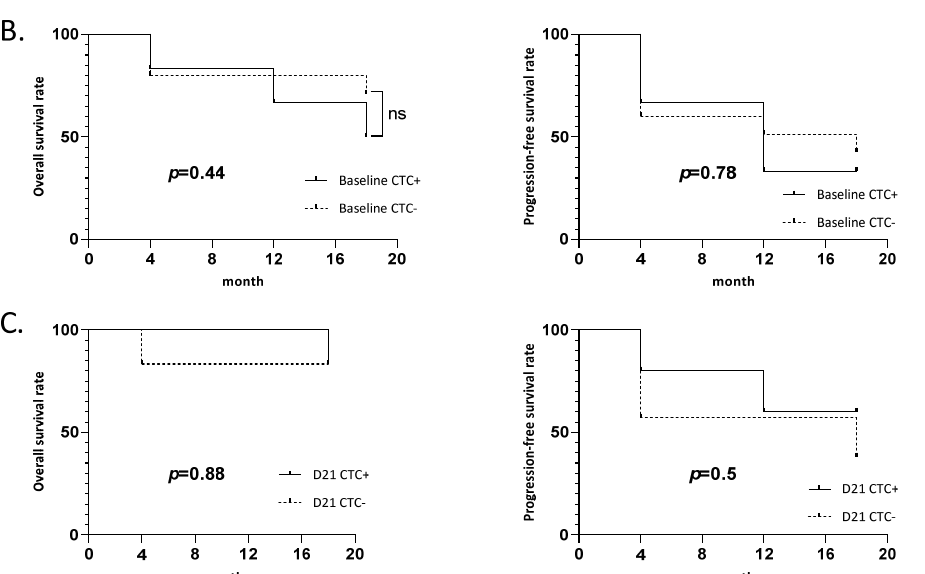
Figure 2. Survival curves: ( A ) Overall survival and progression-free survival of early responder. (R4: responder at 4 months post treatment, NR4: nonresponder at 4 months post treatment). ( B ) Overall survival and progression-free survival of patients depending on CTC at baseline. ( C ) Overall survival and progression-free survival of patients depending on CTC at day 21 (D21).